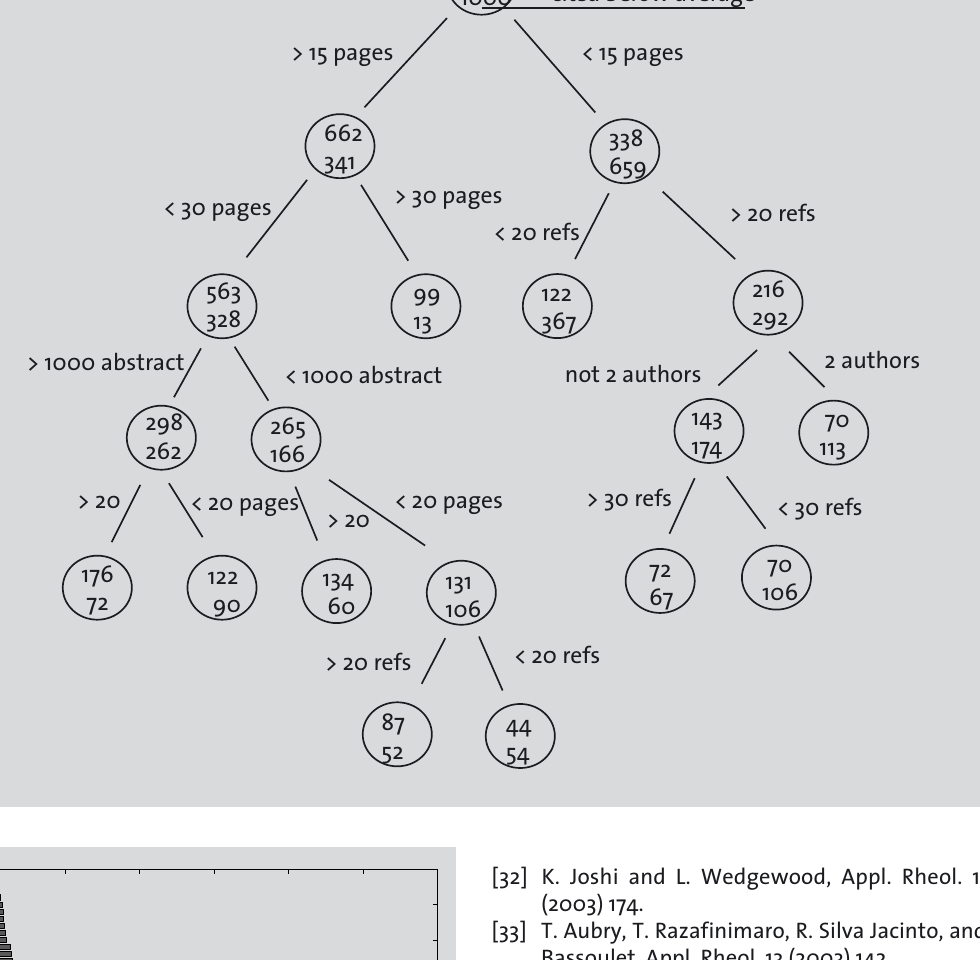
than 5, i.e., if published in 1996, these articles should have been cited 50 times until the end of 2005. Fig. 8 (above): Sample classification tree highlighting relevant impact criteria [44, 45]. Two groups, each consisting of 1000 members are under study, The ‘top’ group has been cited above average, the ‘bottom’ group below average. ‘refs’ stands for number of cited references, ‘abstract’ for characters within the abstract of an article. The rather bad reso- lution represents the large uncertainty in the data and a limited predictive power of the classification scheme which is a result by its